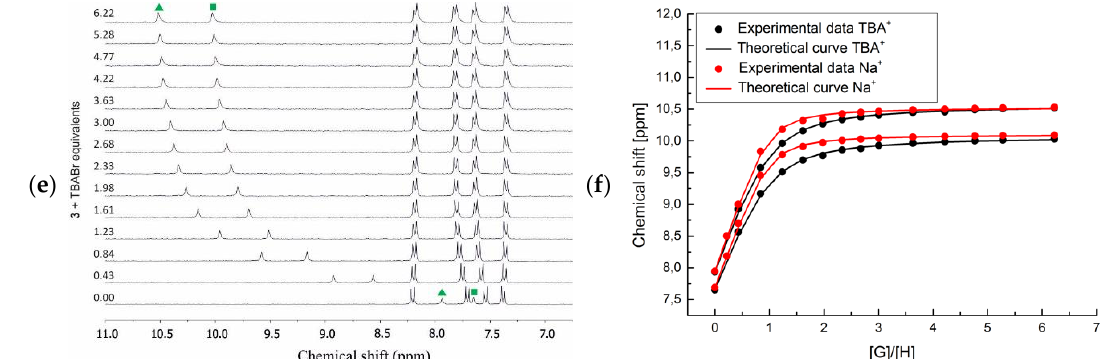
Figure 3. Titration of receptors 1 – 3 (from top-to-bottom) with TBABr in MeCN- d 3 : ( a , c , e ) Stacked 1 H NMR spectra in the urea and aromatic C-H protons range and ( b , d , f ) corresponding binding isotherms in the absence (black curves) and presence of 1 eq. NaClO 4 (red curves). Profiles based on the chemical shifts ( δ , ppm) of the urea protons.